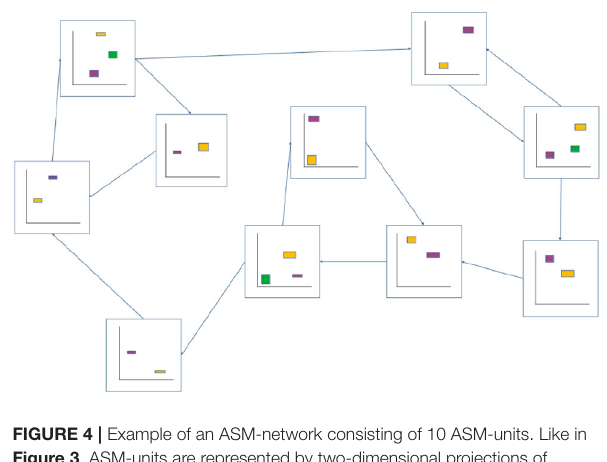
TABLE 1 | Symbols for model parameters and